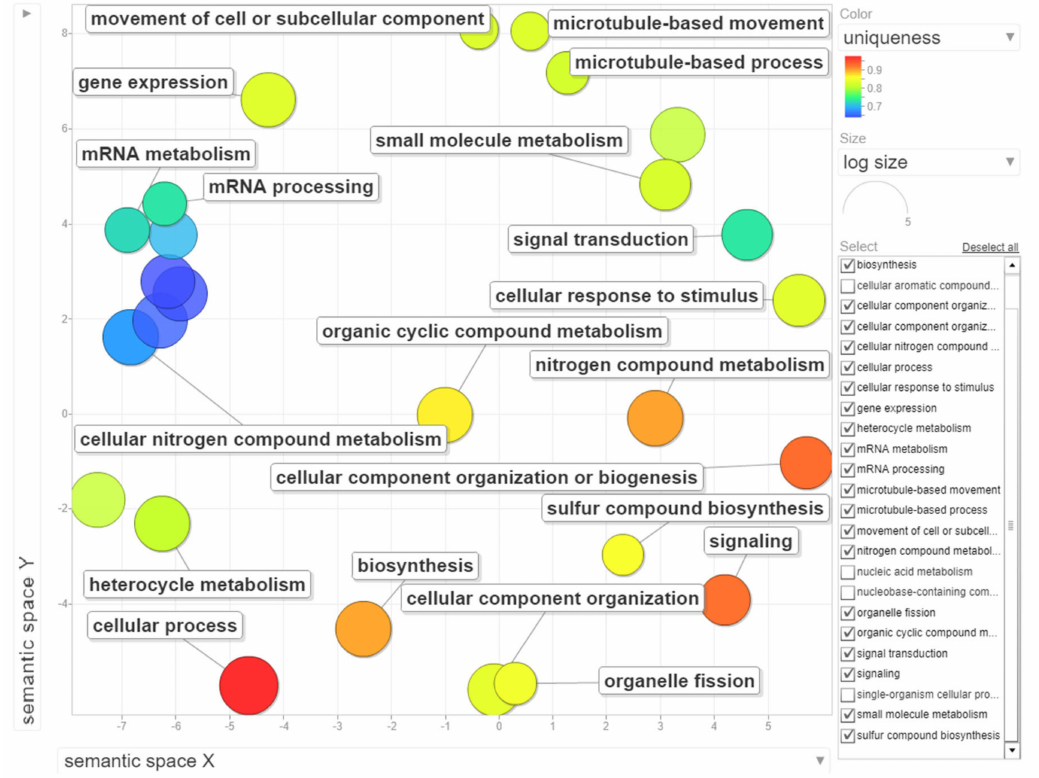
Figure 6. Gene ontology (GO) enrichment analysis of genes with statistically significant up-regulated changes during B chromosome elimination. REVIGO was used to summarize and visualize the enriched GO terms related to biological process. Circles depicted by filled color show significantly enriched GO terms with log 10 p -value < 0.05. Similar GO terms are grouped based on semantic